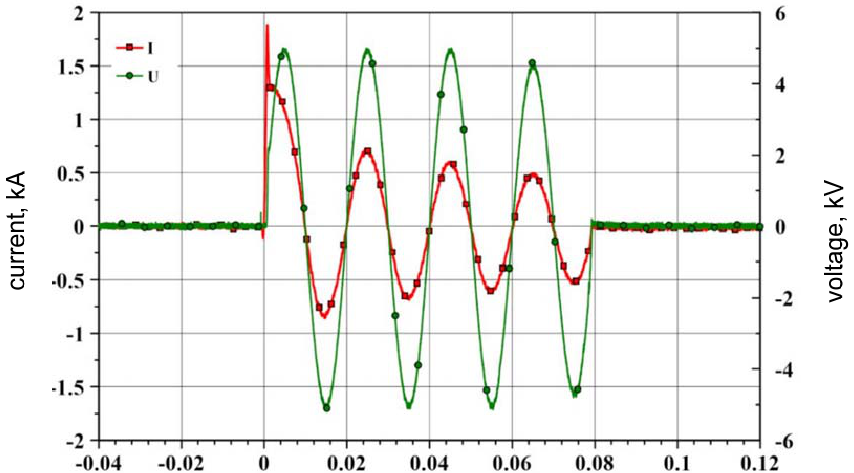
Energies 2021 , 14 , x FOR PEER REVIEW 6 of 23 Figure 4. The course of the short-circuit current and the measured voltage at the limiter—short-circuit test No. 1. ( T 0 = 72 K). I—current, U—voltage.